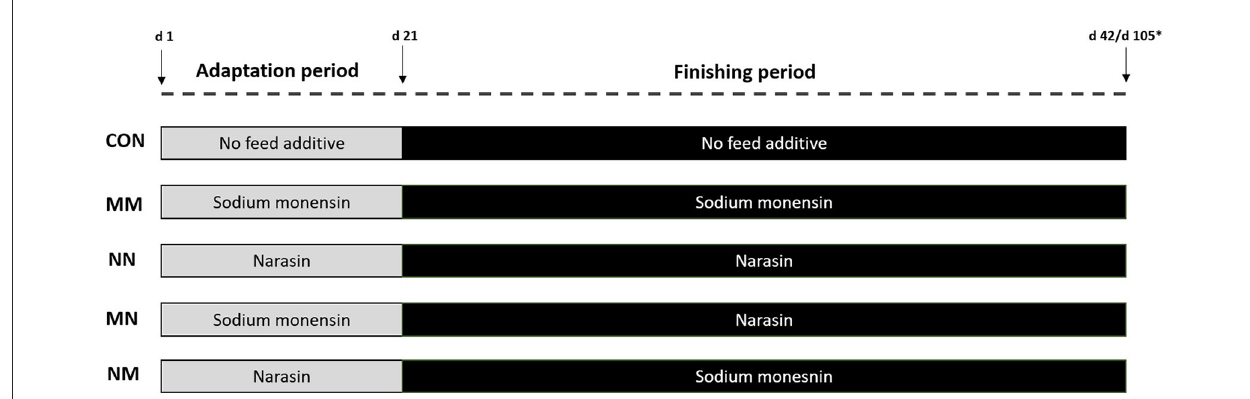
FIGURE1 Schematic representation of the treatments. The adaptation period consisted of 21 days. During the adaptation period, steers were fed three step-up diets which gradually (7 days in each step) decreased the roughage source (sugarcane bagasse) from 23 to 18% (Adap. 1), to 13% (Adap. 2), and to 8% (Adap. 3) and increased concentrate accordingly. From days 22 to 42 (Exp. 1) or day 105 (Exp. 2), steers were fed the finishing diet containing 8% of roughage (sugarcane bagasse). Treatments were as follows: Control (CON): no feed additive in the basal diet during the entire feeding period; Sodium monensin (MM) at 25 mg/kg DM during the entire feeding period [adaptation and finishing periods (Rumensin 100, Elanco Brazil, São Paulo, SP, Brazil)]; Narasin (NN) at 13 mg/kg DM during the entire feeding period (adaptation and finishing periods; Zimprova 100, Elanco Brazil, São Paulo, SP, Brazil); Sodium monensin at 25 mg/kg DM during the adaptation period and narasin at 13 mg/kg DM during the finishing period (MN); and narasin at 13 mg/kg DM during the adaptation period and sodium monensin at 25 mg/kg DM during the finishing period (NM). *Exp. 1 lasted for 42 days and Exp. 2 lasted for 105 days.